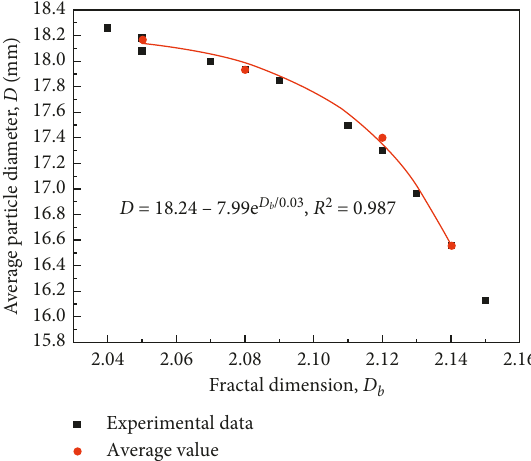
Figure 10: Relationship between average particle size and fractal